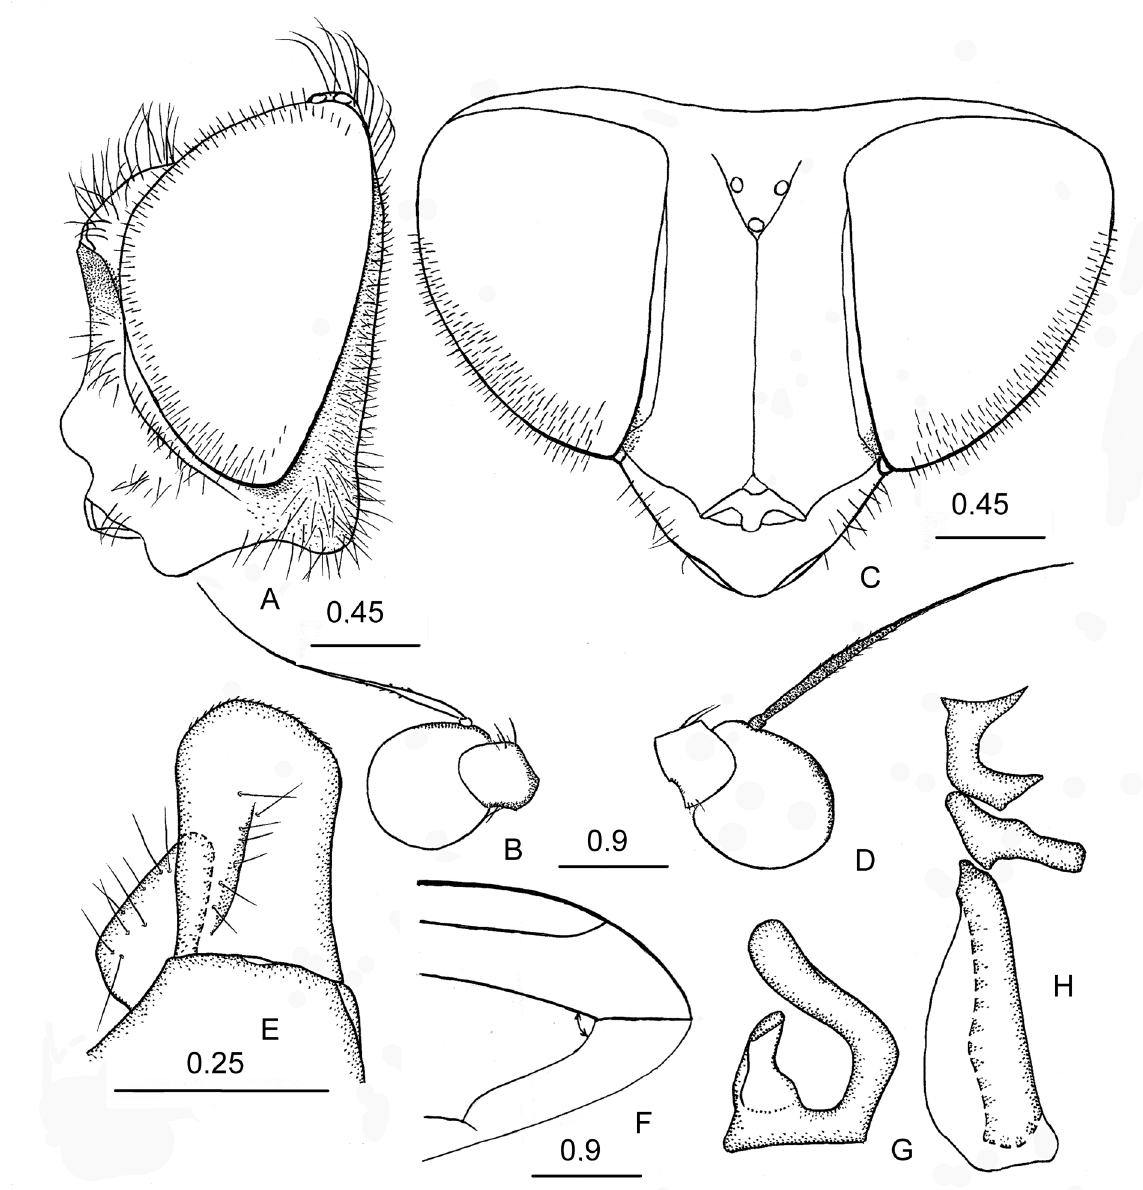
Fig. 48. Cheilosia ( Cheilosia ) pica sp. nov. A–B, E–H = holotype, ♂ (CSCA), C–D = paratype, ♀ (CNC). A . Head, lateral view. B, D . Antenna, lateral view of pedicel and basoflagellomere. C . Head, dorsal view. E . Surstylus and gonocercus, lateral view. F . Tip of wing. G . Superior lobe of hypandrium, lateral view. H . Aedeagus and aedeagal apodeme, lateral view. Scale bars indicated in